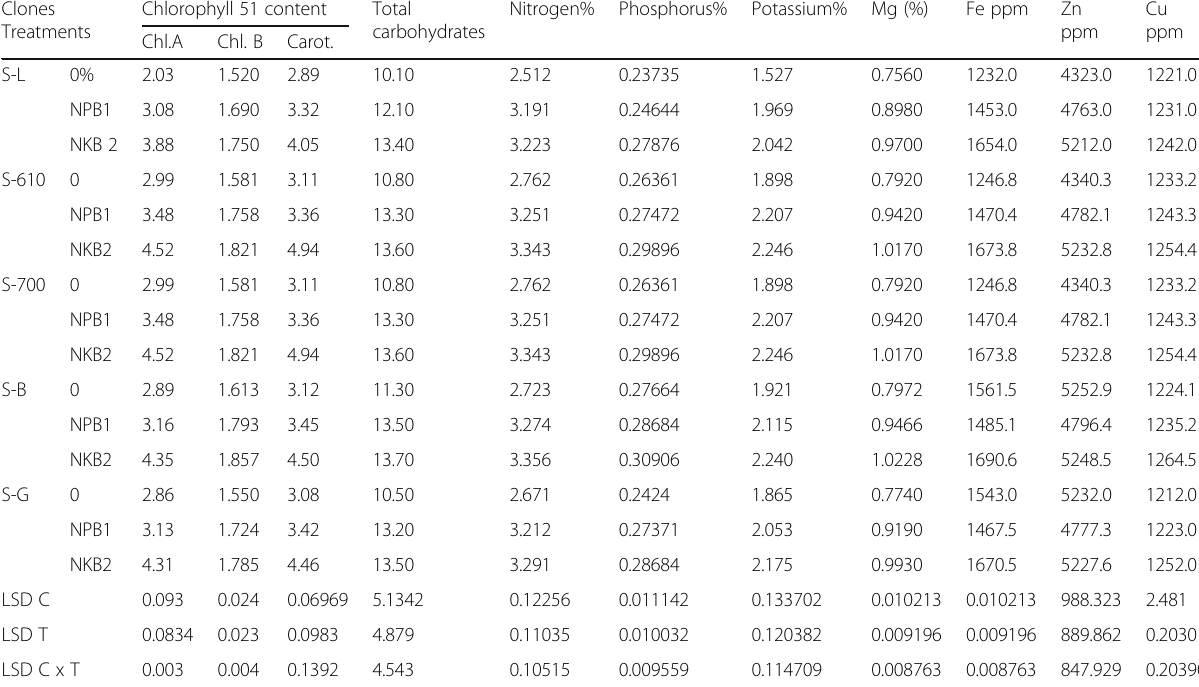
Table 6 Effect of NPB rates on leaves chemical contents of jojoba clones at 3 years Clones